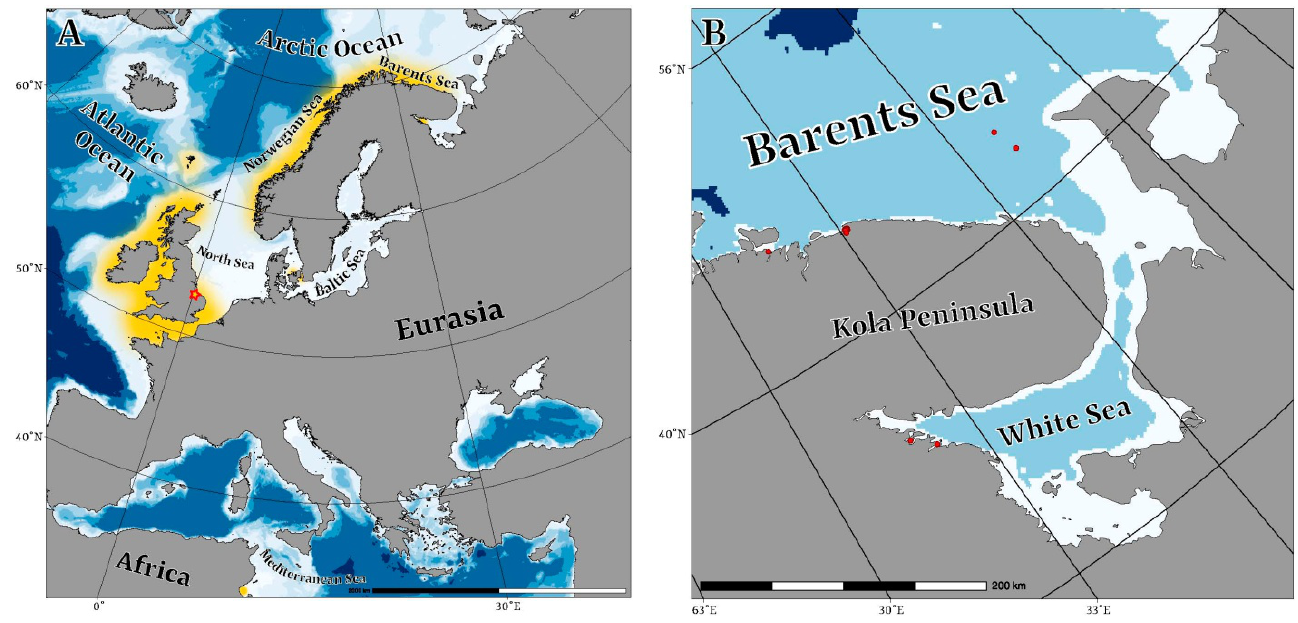
Figure 1. Maps showing: ( A )—distribution of Philinossima denticulata in the world, ( B )—collection sites of P. denticulata in the White and Barents Seas.